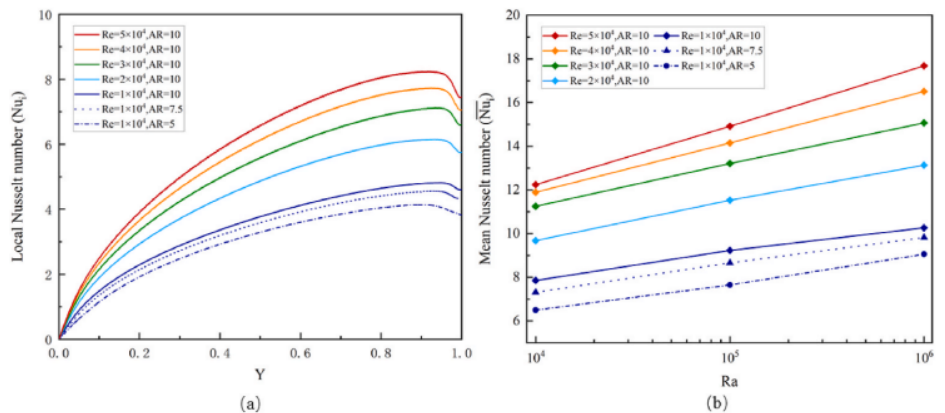
Figure 29. Variation of ( a ) local Nusselt number and ( b ) mean Nusselt number of the mPCM. Reprinted with permission from Ref. [51]. 2021, Elsevier.